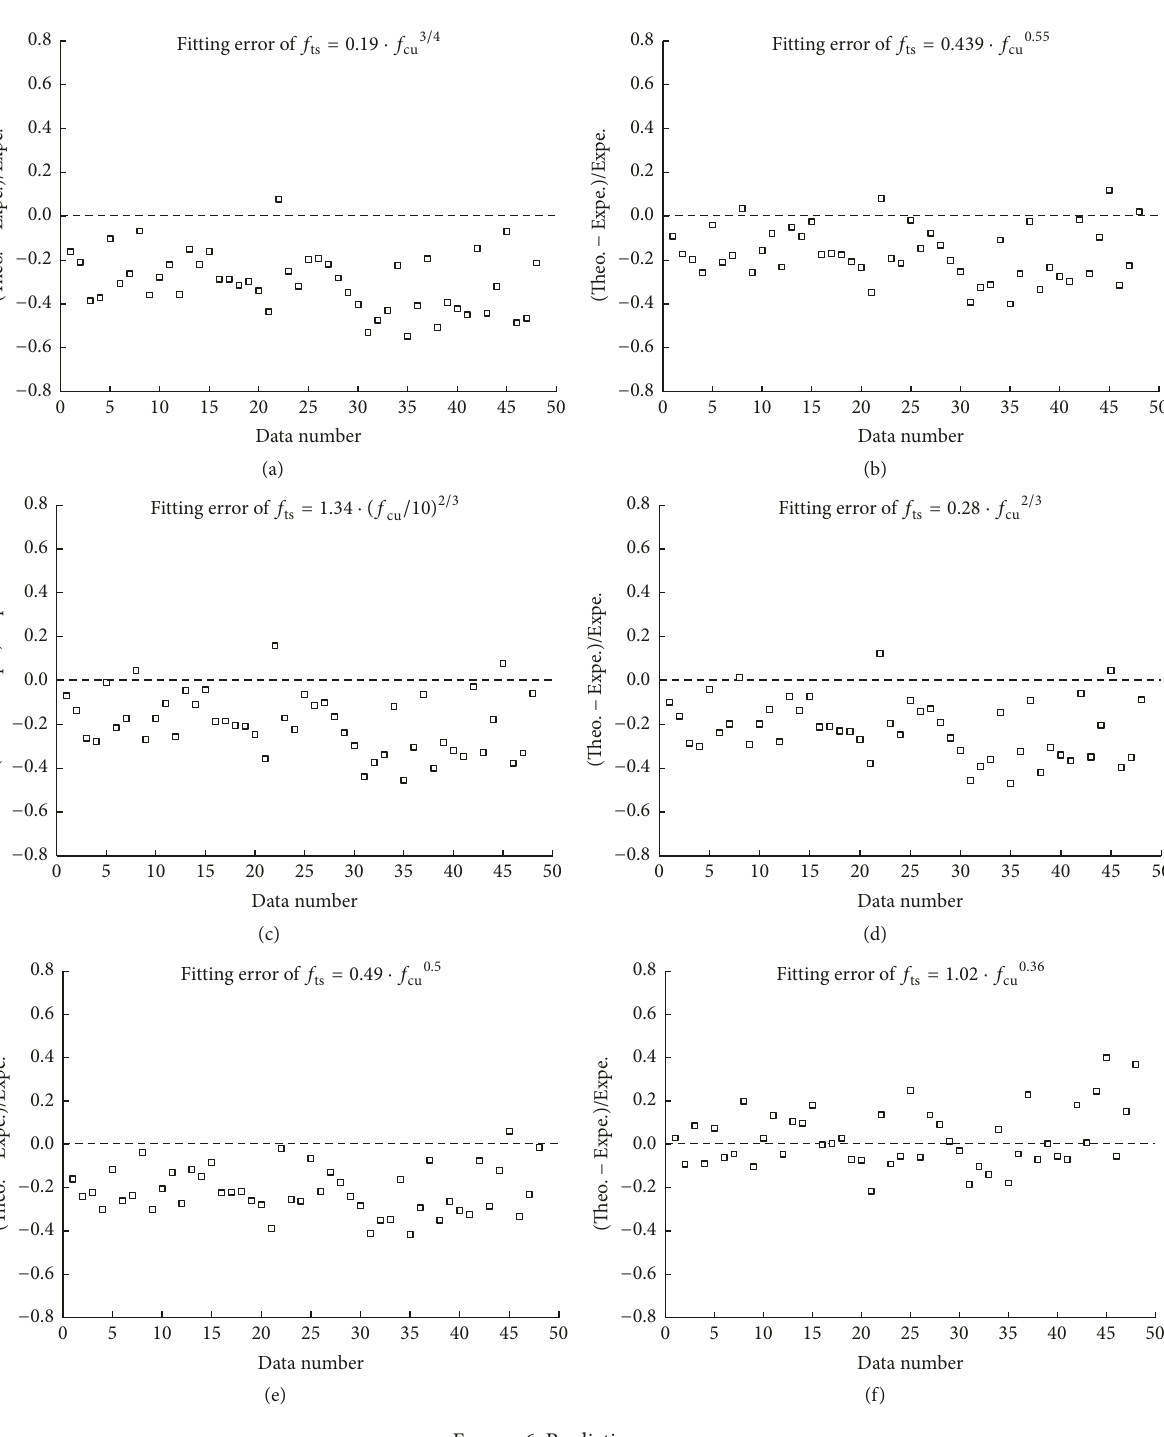
Figure 6: Prediction